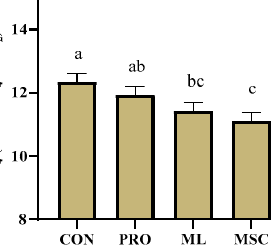
Figure 1. Relative proportion of carbon dioxide (CO 2 ) and methane (CH 4 ) as affected by PRO, ML, and MSC. Experimental diets included a diet with concentrate at 500 g kg − 1 of diet dry matter without supplementation (CON) or top-dressed with propolis (PRO), dried moringa leaves (ML), or moringa seed cake (MSC). abc Least square means sharing no common superscripts differed significantly ( p ≤ 0.05) according to Tukey’s method.